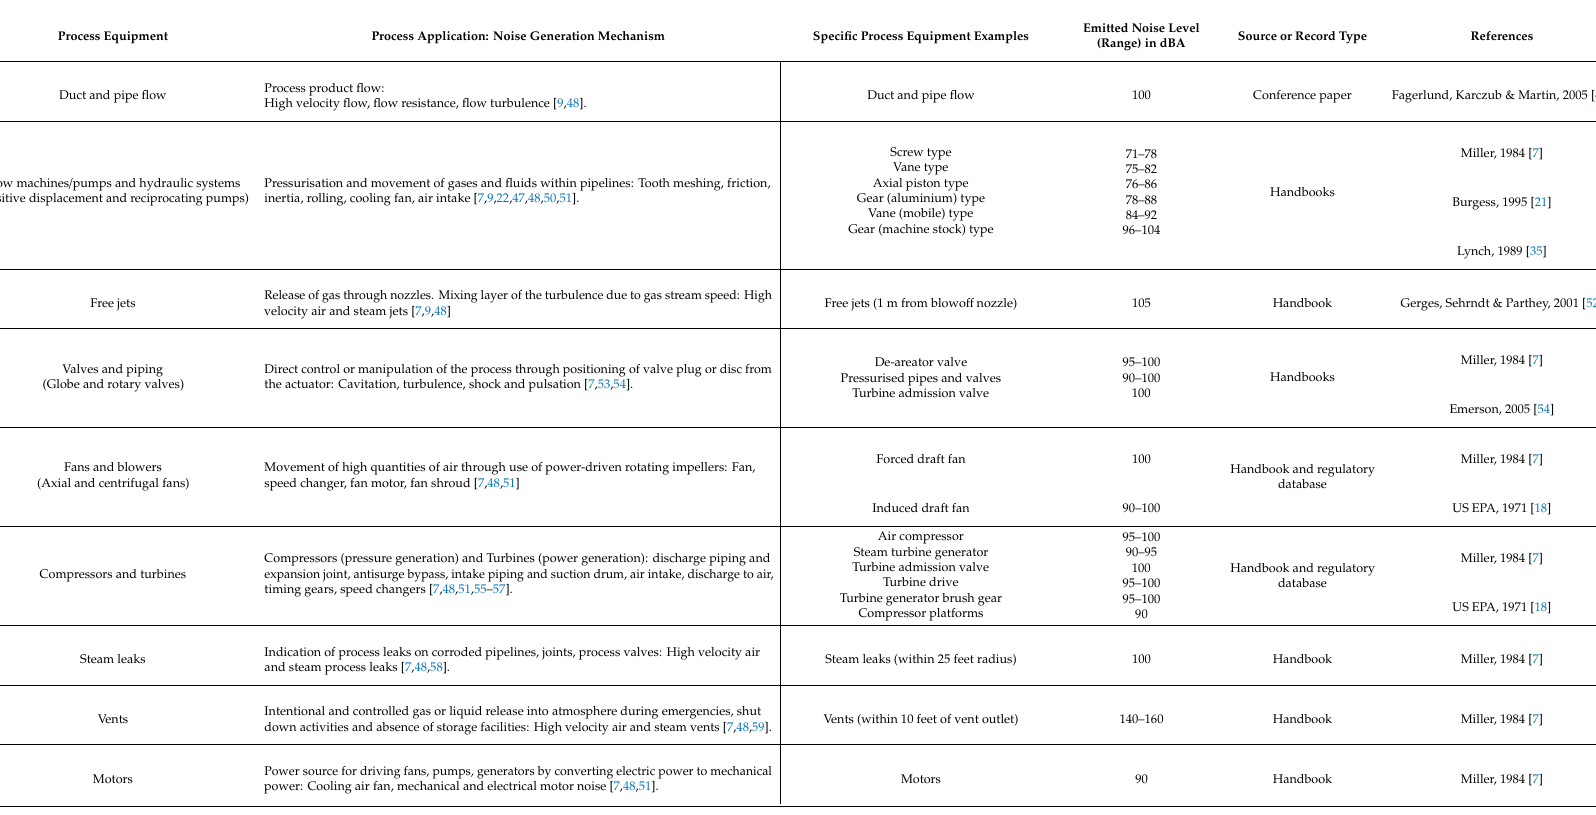
Table 3. Process equipment, applications, noise generation mechanisms and resultant noise levels in chemical manufacturing